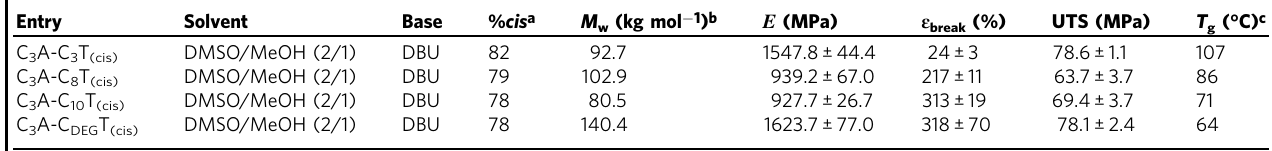
Table 3 Characterisation of C 3 A-C X T polymers obtained from the polymerisation of C 3 A and various thiols using 1 mol% base at [C 3 A] = 1 M.